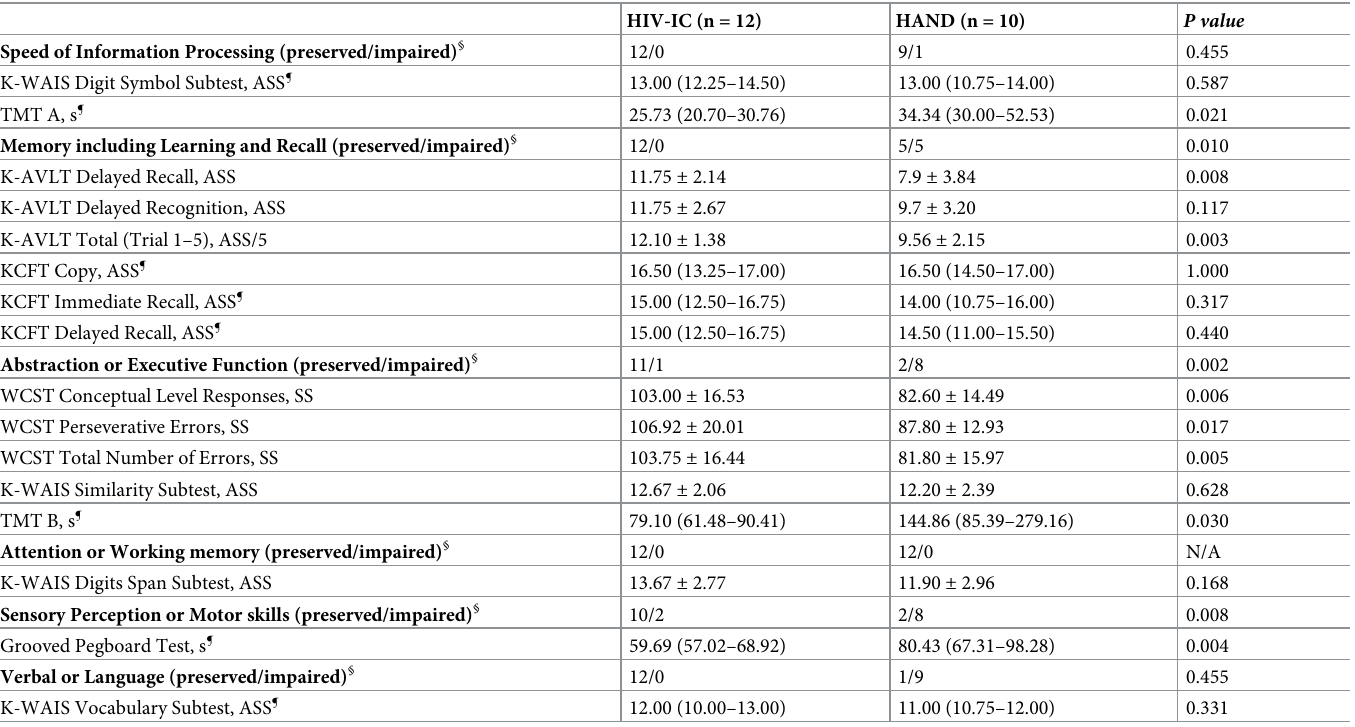
Table 1. Neuropsychological status of HIV-IC and HAND.